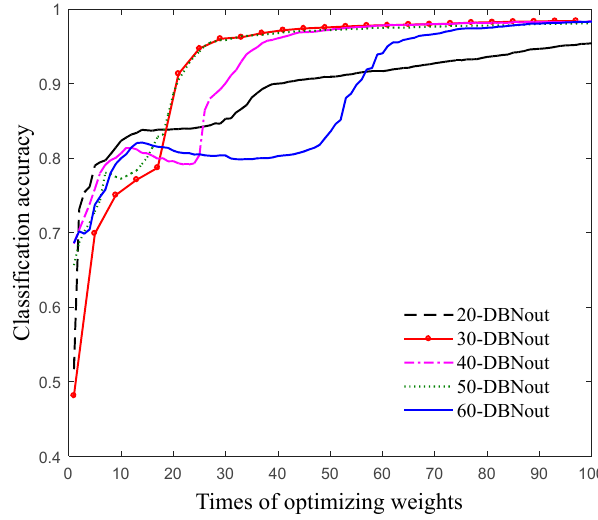
Figure 8. Trend of classification accuracy with di ff erent top-level